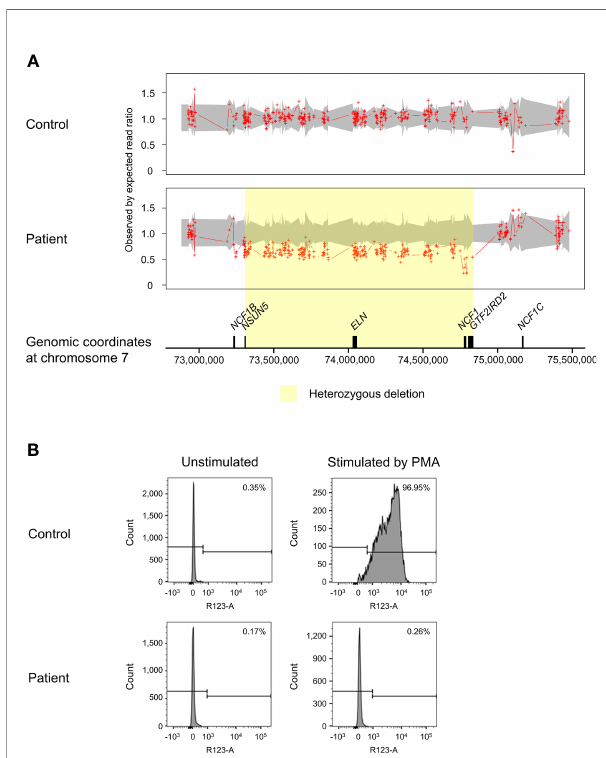
FIGURE 2 | Copy number variation (CNV) analysis on chromosome 7q11.23 and assessment of NADPH oxidase activity. (A) The patient was found to have a biallelic deletion of NCF1 localized within the 1.53Mb heterozygous deletion associated with Williams-Beuren syndrome (WBS) (shaded in yellow). The breakpoints of WBS deletion occurred from chromosome 7:73,303,201- 74,836,526, affecting 27 genes. Biallelic loss of NCF1 leads to autosomal recessive chronic granulomatous disease (CGD). Aortic stenosis observed in the patient is consistent with the haploinsuf fi ciency of ELN . Ratio of 1.5 indicates one-copy duplication, 1.0 indicates normal copy state, 0.5 indicates one-copy deletion and 0 indicates two-copy deletion. Grey shade represents the 95% con fi dence interval of expected read ratio. Each red plus symbol indicates the genomic position being probed. Size of genes (black- fi lled boxes) was approximate and not drawn to scale. (B) Assessment of neutrophil oxidative burst activity using dihydrorhodamine (DHR) fl ow cytometry assay. Upon stimulation by phorbol 12-myristate 13-acetate (PMA), the patient showed no change in the fl uorescence intensity of rhodamine 123 (right panel). This result is consistent with CGD that lacks normal neutrophil oxidative burst activity. The percentage in the histograms indicates the proportion of neutrophils that produced reactive oxygen species (ROS). PMA, phorbol 12-myristate